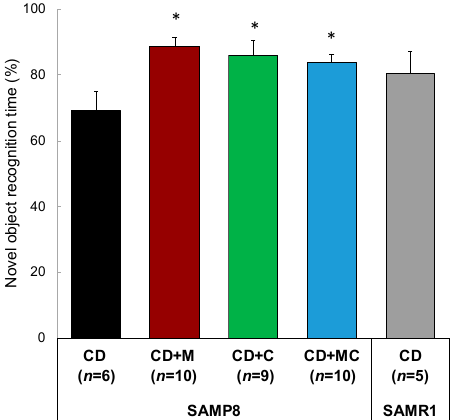
Figure 3. Improved memory retention due to CCP and MFGM intake. Each value represents the mean ± SEM. Asterisks denote significant differences relative to SAMP8 control (*, p < 0.05 Tukey–Kramer significant difference method).